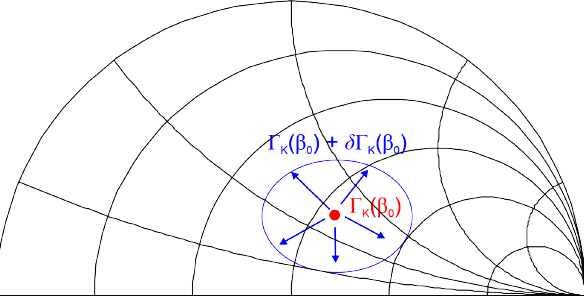
Figure 3. Technological variations of the passive block act load-pulling the active